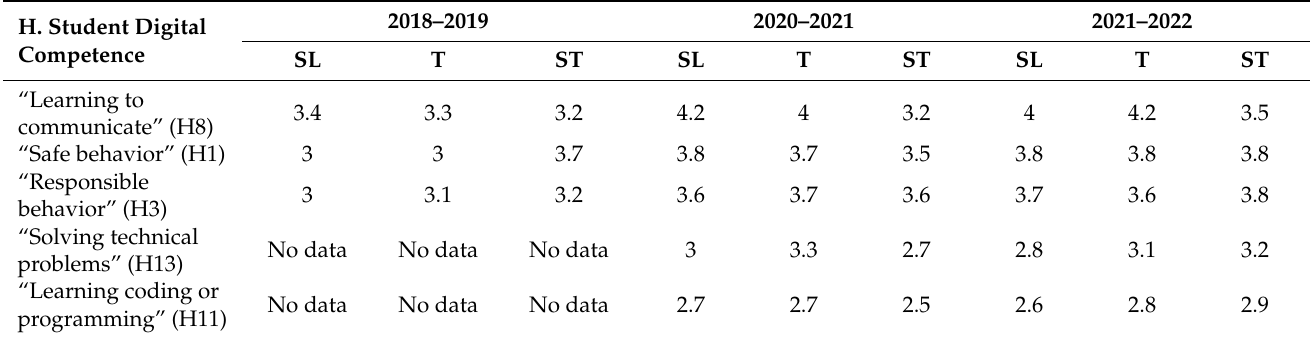
Table 9. Descriptive statistics on Student Digital Competence.